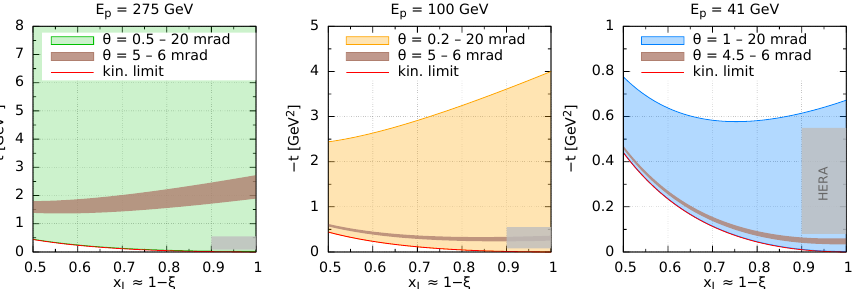
Figure 6: Final proton tagging. x , t range of the proton tagged by the EIC detector L for three proton energies, 275 GeV, 100 GeV and 41 GeV. The brown strip marks a small ( ∼ 1 mrad) region not covered by the current detector